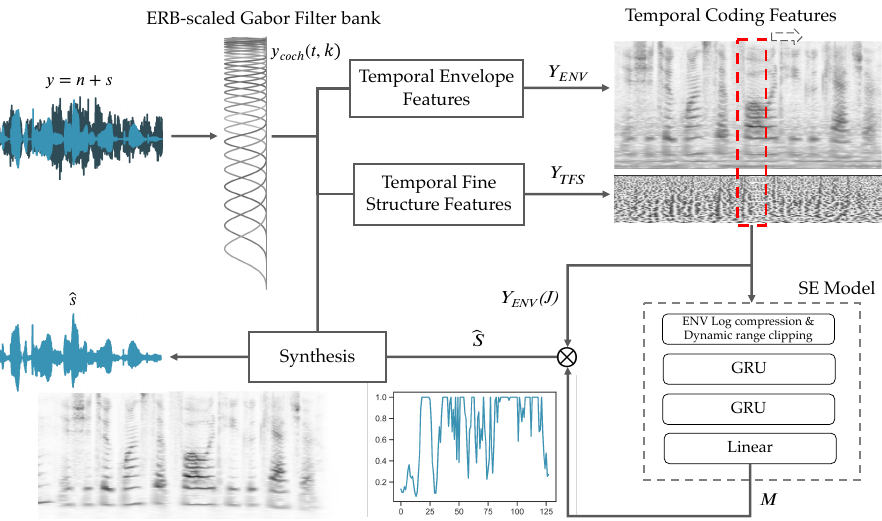
Figure 1. Detailed illustration of the components of the proposed speech enhancement inference algorithm. The input signal is filtered by an ERB filter bank. The outputs y coch are transformed to auditory-motivated temporal envelope and fine structure representations. The Speech Enhancement (SE) model processes J frames on every iteration and predicts the envelope gains of the Jth frame. Predictions are used to modulate the unprocessed envelopes, and the enhanced audio waveform ˆ s is synthesized using the sub-band y coch